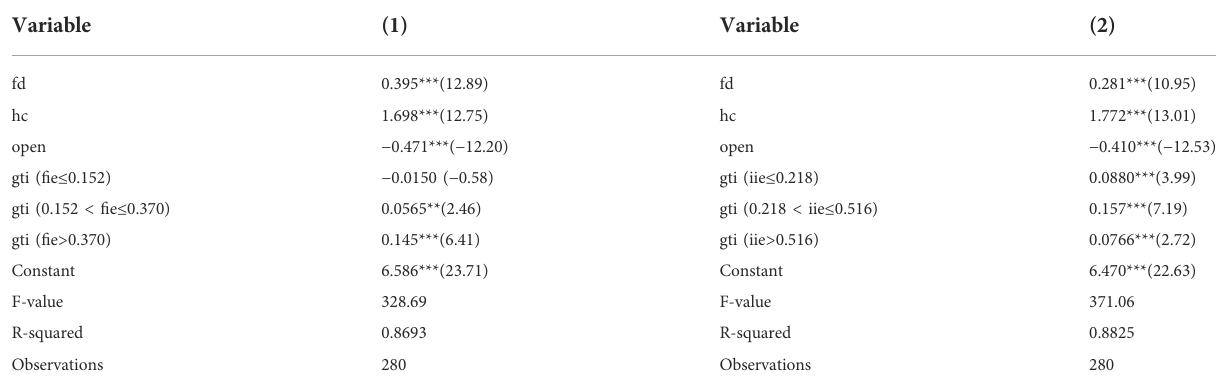
TABLE 7 Threshold model estimation